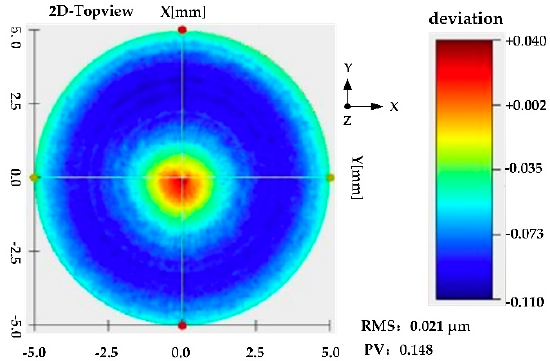
Figure 6. Test results of the rotating paraboloid, detected by LuphoScan.